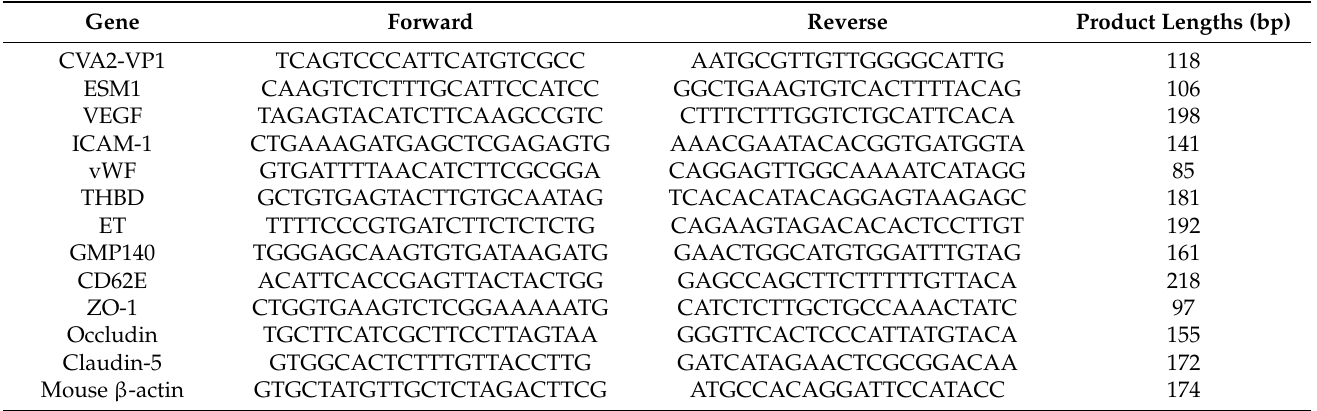
Table 1. Primers